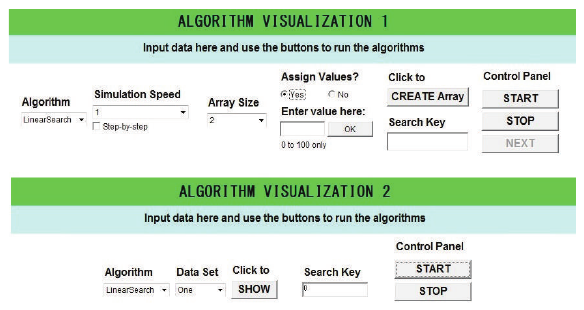
Figure 3: Input and control panels for AlgoVis1 and